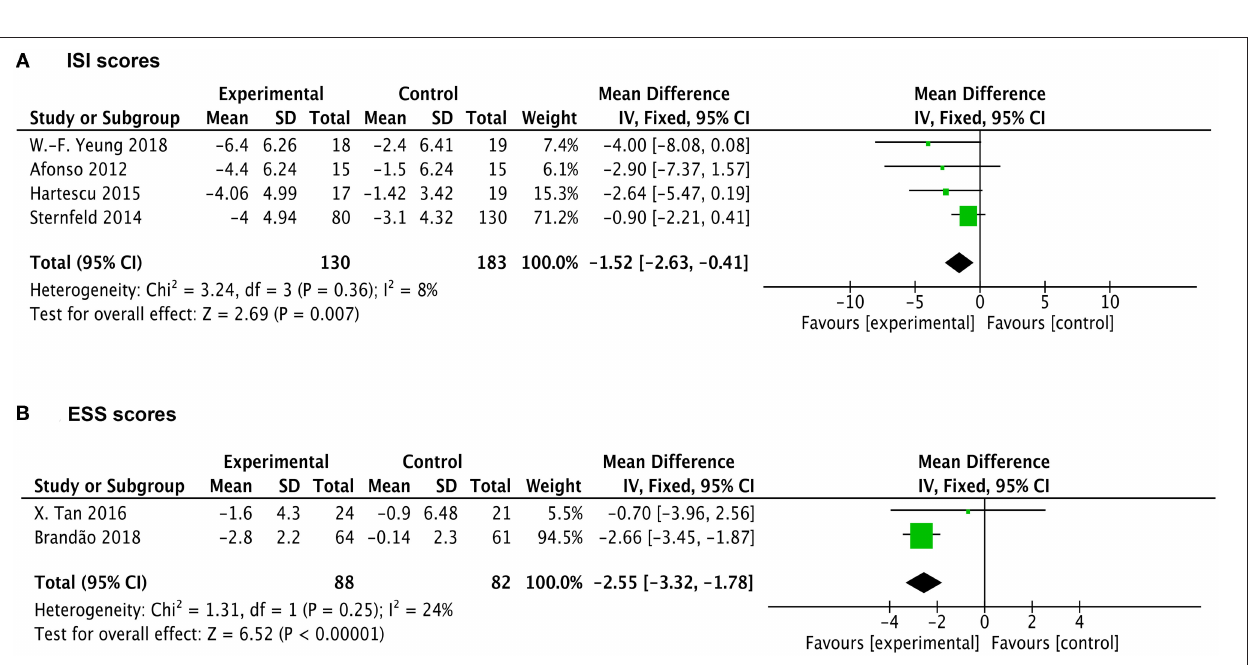
FIGURE 4 | Forest plots of ISI and ESS scale outcomes in overall analysis. (A) Forest plot of ISI scale outcomes. (B) Forest plot of ESS scale outcomes.